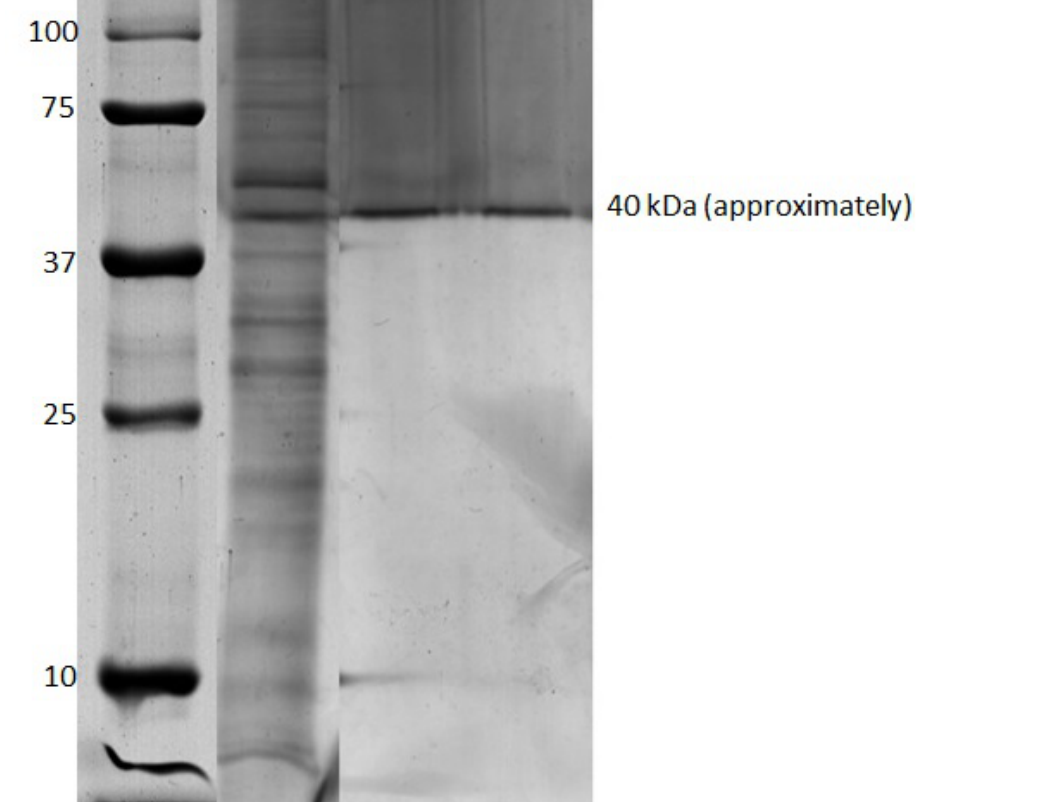
et al. 2011, Ju et al. 2012, Moon et al. 2014, Nascimento et al. 2017 and Elhoul et al. 2015 from Bacillus subtilis TKU007, Streptomyces sp. XZNUM 00004, Lyophyllum shimeji , Mucor subtilissimus UCP 1262 and Streptomyces koyangensis TN650, respectively. The literature indicates that most of fibrinolytic enzymes of microbial origin are serine proteases (Sun et al.